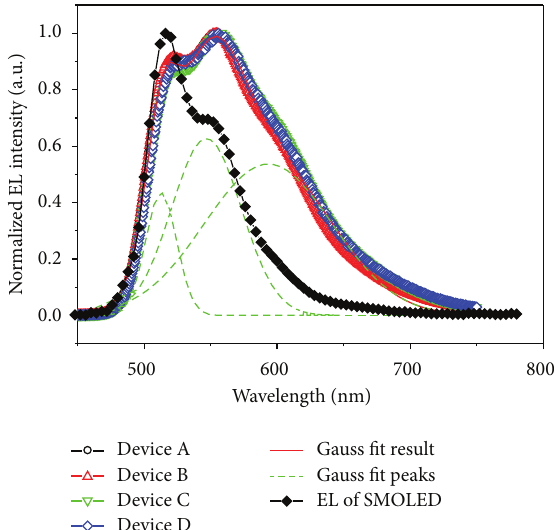
Figure 3: The normalized EL spectra of devices A, B, C, and D at 20 V and Gauss fit results. EL spectrum of SMOLED was shown for comparing.